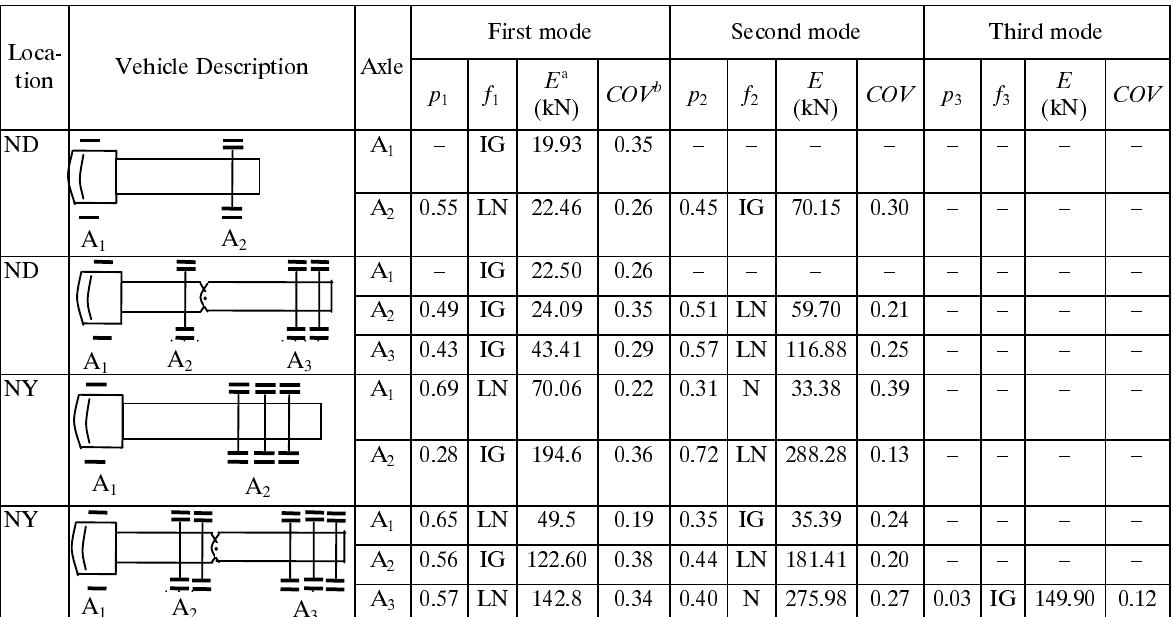
Table 1. Probabilistic descriptions of typical vehicle axle weights